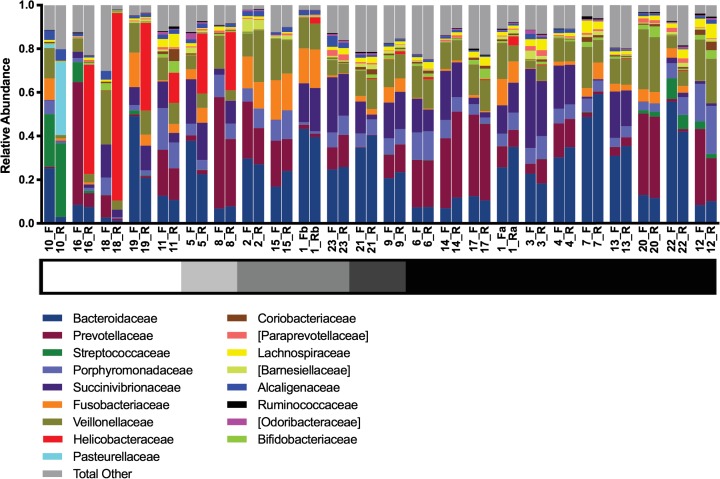
Bacterial community composition of fecal (F) and rectal (R) samples.Each animal in the study is listed by study ID listed in Table 1. The relative abundances of sequences classified to the order level with abundances <1% omitted for convenience. Animal #1 in this study was sampled twice 27 days apart. Thus, the samples are designated as 1_Fa and 1_Ra and 1_Fb and 1_Rb. A greyscale bar under the study ID indicates the relative amount of material on the rectal swab (white = FVFM [0] and black = maximal [4]).